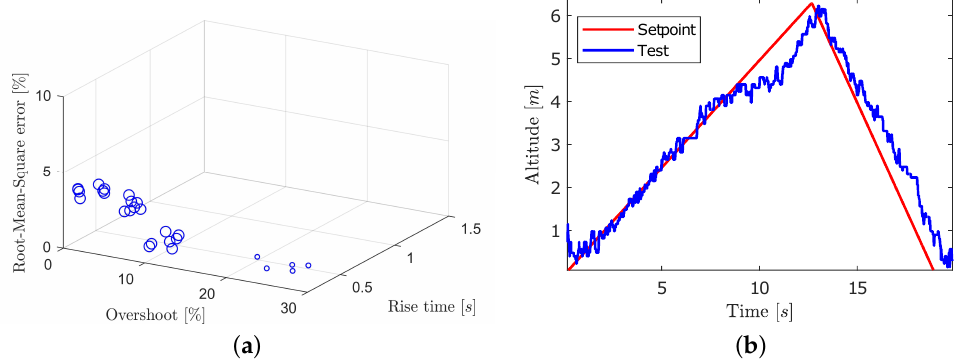
Figure 15. ( a ) Pareto front altitude. ( b ) Altitude axis response